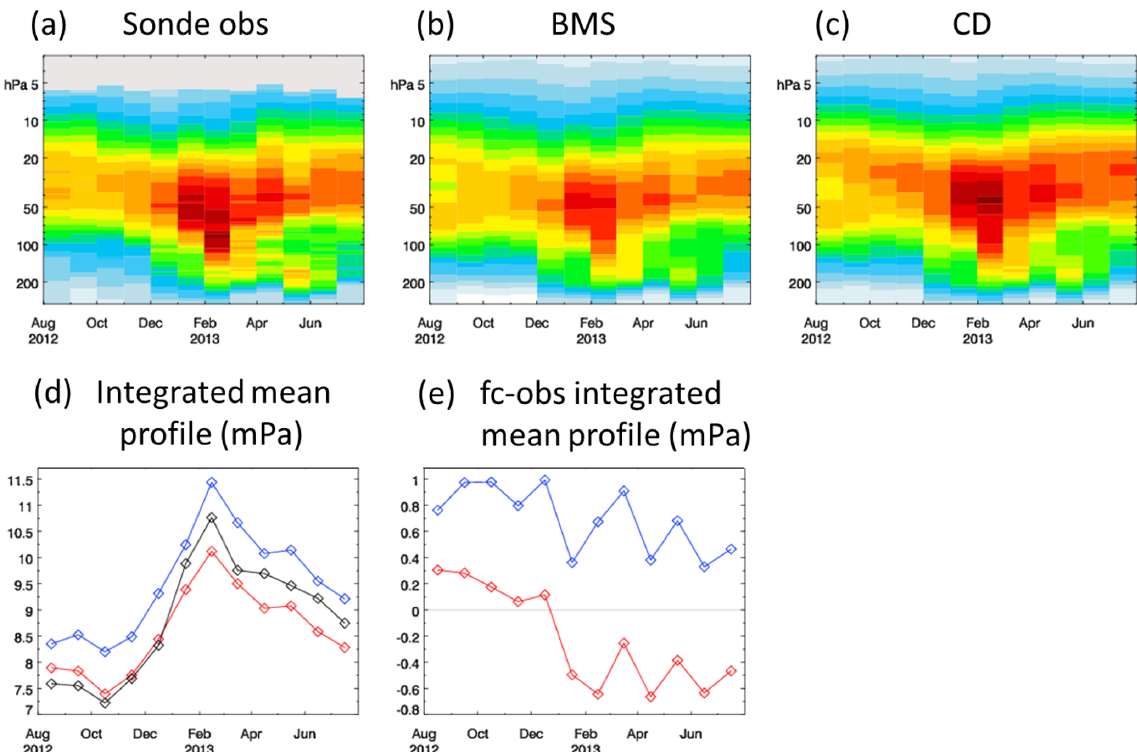
Figure 5. Monthly averaged time series of the vertical stratospheric profiles of ozone (mPa), for the period August 2012–July 2013, over the European Alpine Hohenpeissenberg station (47 ◦ N, 11 ◦ E), from the observed profiles (a) , the model experiment with the new ozone scheme (b) , and a model experiment using the default ozone (c) . The values for the integrated mean vertical profiles are shown in panel (d) for observations (black), model experiment using default option for ozone (blue) and model experiment using the new ozone scheme (red). Panel (e) shows the corresponding differences in the integrated mean vertical profile between the two forecast (fc) runs and the observations (obs), for the experiment using default option for ozone (blue) and the experiment using the new ozone scheme